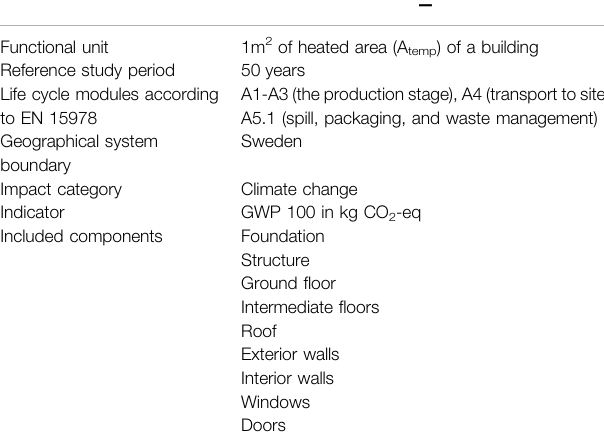
TABLE 3 | Methodological